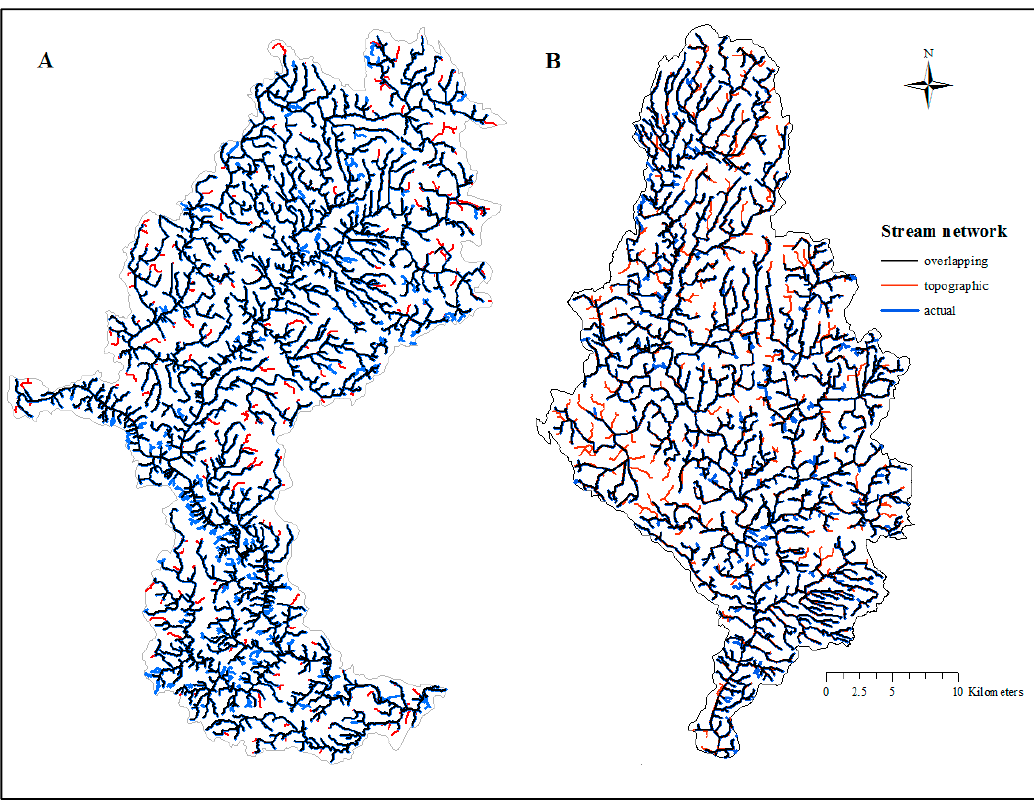
Figure 3. Comparison of the actual stream network to topographically derived stream networks demonstrating higher stream density in the actual stream network versus the topographically extracted stream network in the Conestogo ( A ) and Upper Grand ( B ) sub-basins of the GRB.